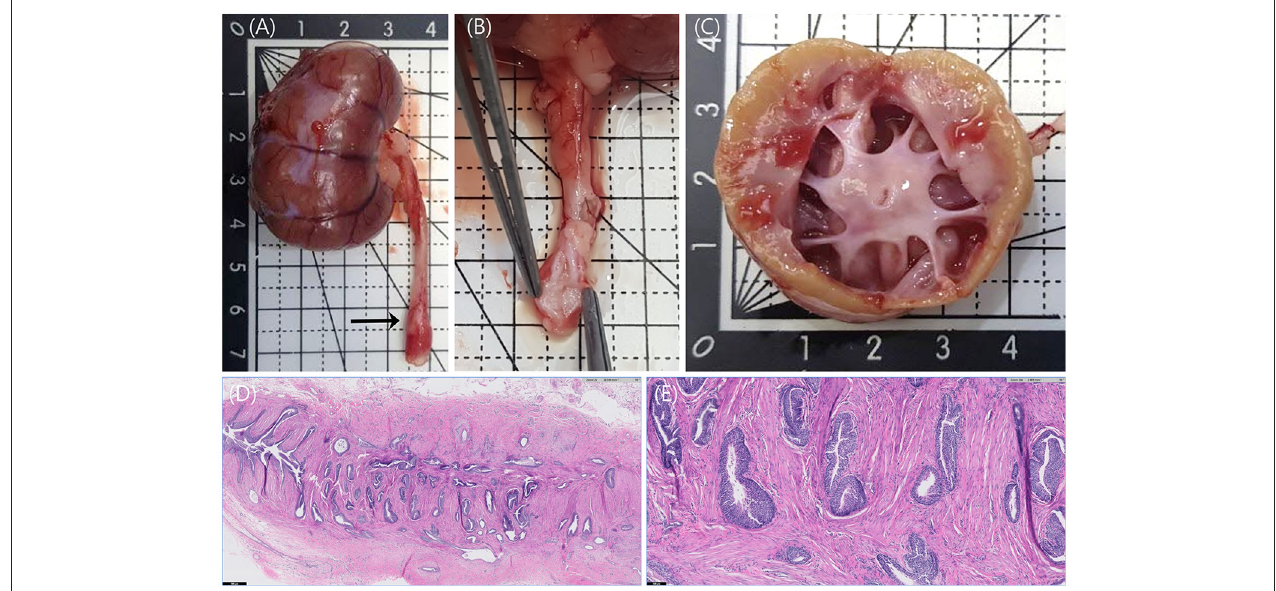
FIGURE 3 | Anatomy of right kidney and right ureter and histopathology of right ureter stained with hematoxylin and eosin (H&E) staining. (A) The enlarged right kidney and focally thickened ureter (arrow) were observed. (B) The surface of the thickened ureteral wall was irregularly protruded. (C) When the right kidney was dissected, the renal pelvis was severely dilated, and the cortex was yellowish, unlike the normal reddish-brown color. (D) Numerous invaginated folds of uroepithelium are observed at the right ureteral malformation. H&E, × 20, Scale bar = 500 µ m. (E) Invaginated folds and embedded nests of uroepithelium appear to be entrapped within the smooth muscle layer of the ureter. No epithelial dysplasia is identified. H&E, × 100, Scale bar = 100 µ m.